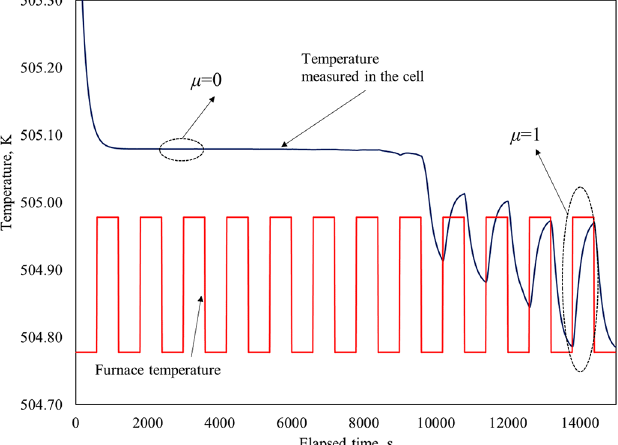
Fig. 4. Penetration ratio m in a fi xed-point realization. Cell temperature (blue) and furnace temperature of the cell (red).